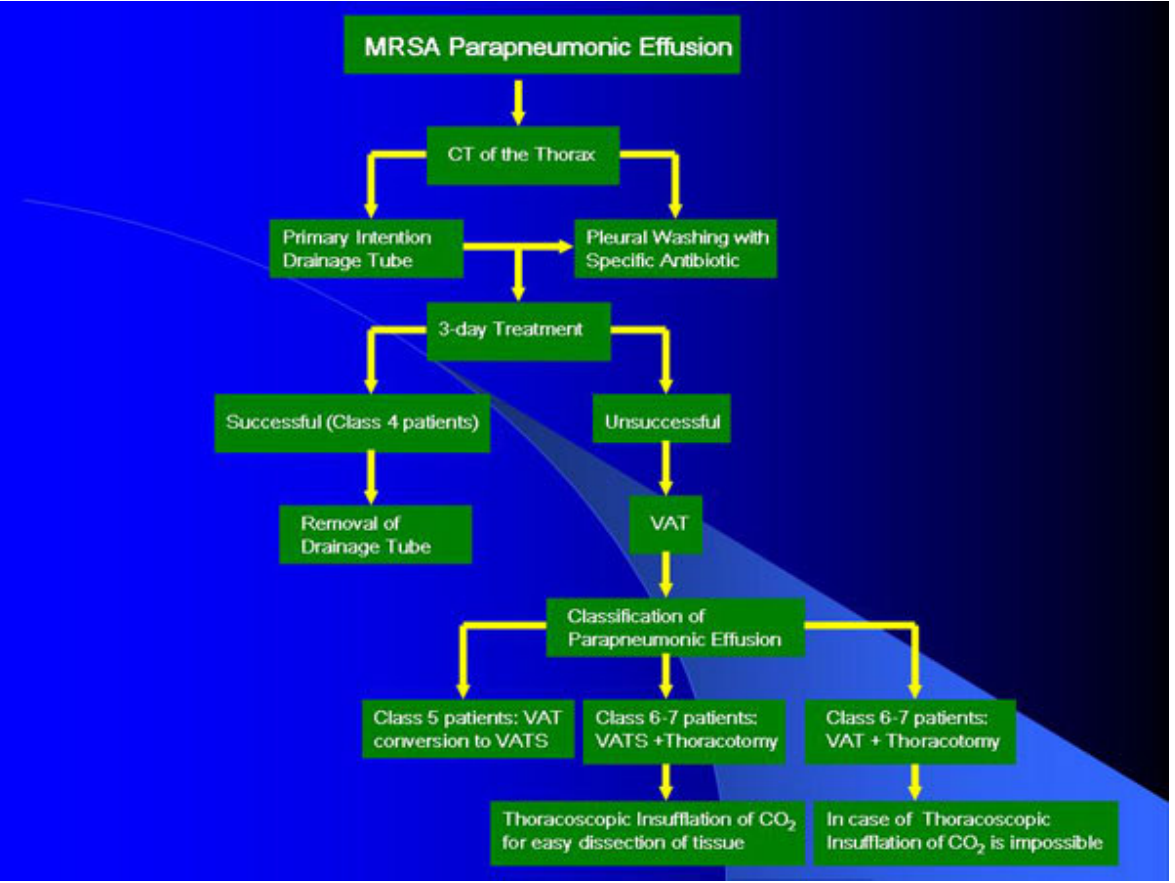
FIGURE 3. The flowchart of MRSA pleural effusion therapeutic approaches, according to our